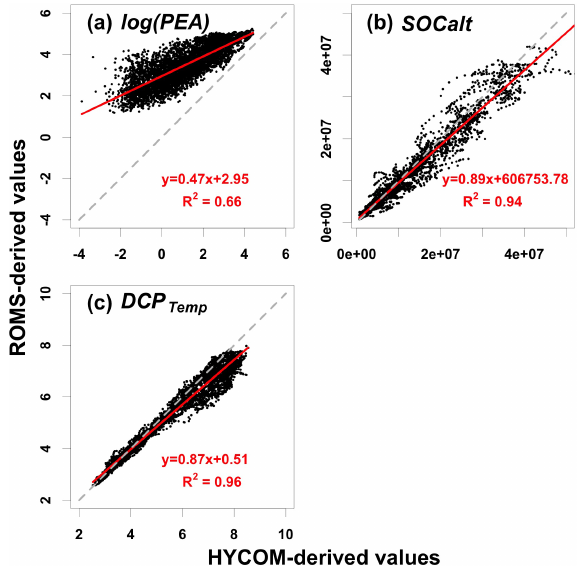
Figure 6. Scatterplots of (a) log(PEA) (unit: log(Jm − 3 )), (b) SO- Calt (unit: mmols − 1 ), and (c) DCP Temp (unit: non-dim) between ROMS and HYCOM simulations. Note that the solid red lines rep- resent linear regression lines, while the dashed grey lines are diag- onals with a slope of 1 and an intercept of 0. Daily data compared are from 2007 to